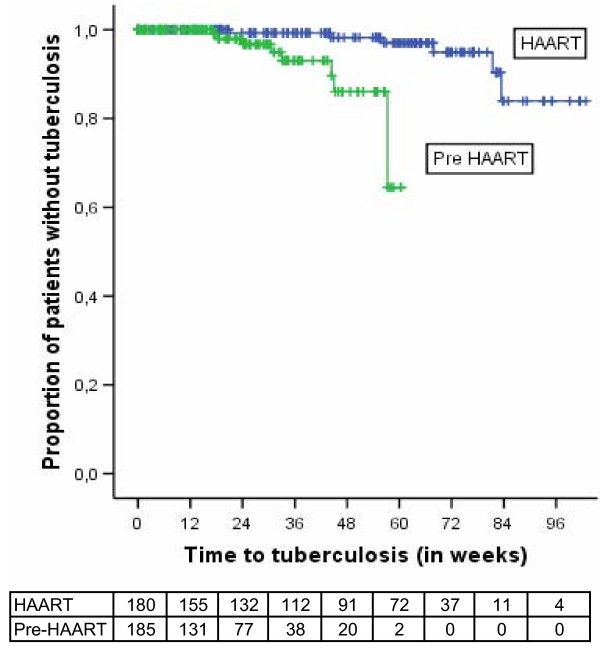
Kaplan Meier estimates of tuberculosis-free survival in the two cohorts, Arba Minch Hospital, 2006. This figure shows the high tuberculosis occurrence in the untreated group. Unlike the mortality rate which was highest in the early weeks, tuberculosis started at about 20 weeks after enrolment (pre-HAART) or after starting treatment (HAART). This could be because patients might have died even before being diagnosed. Additionally, it could be due to the time needed to diagnose new cases.